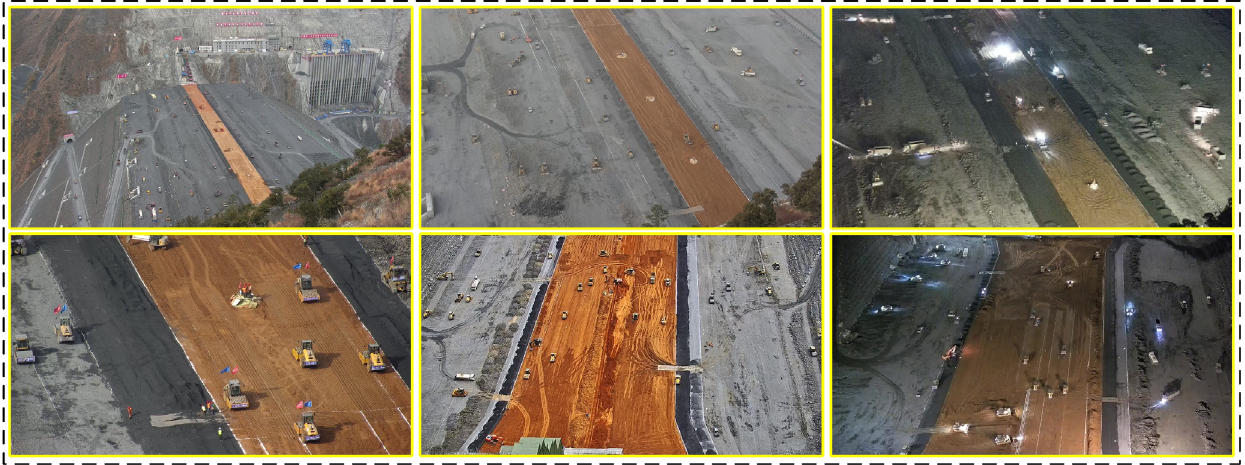
Figure 4. Some examples of large-scene construction site high-definition monitoring